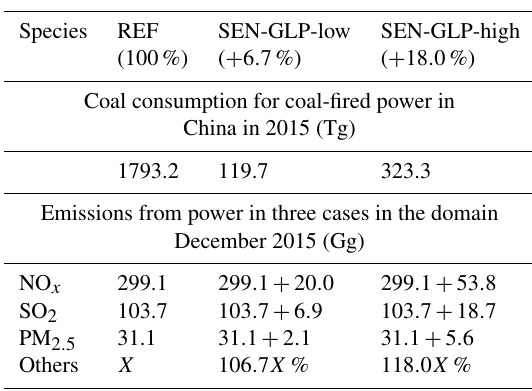
Table 2. Coal consumptions and emissions for the reference case (REF), and the limit cases of low (SEN-GLP-low) and high (SEN- GLP-high). Species